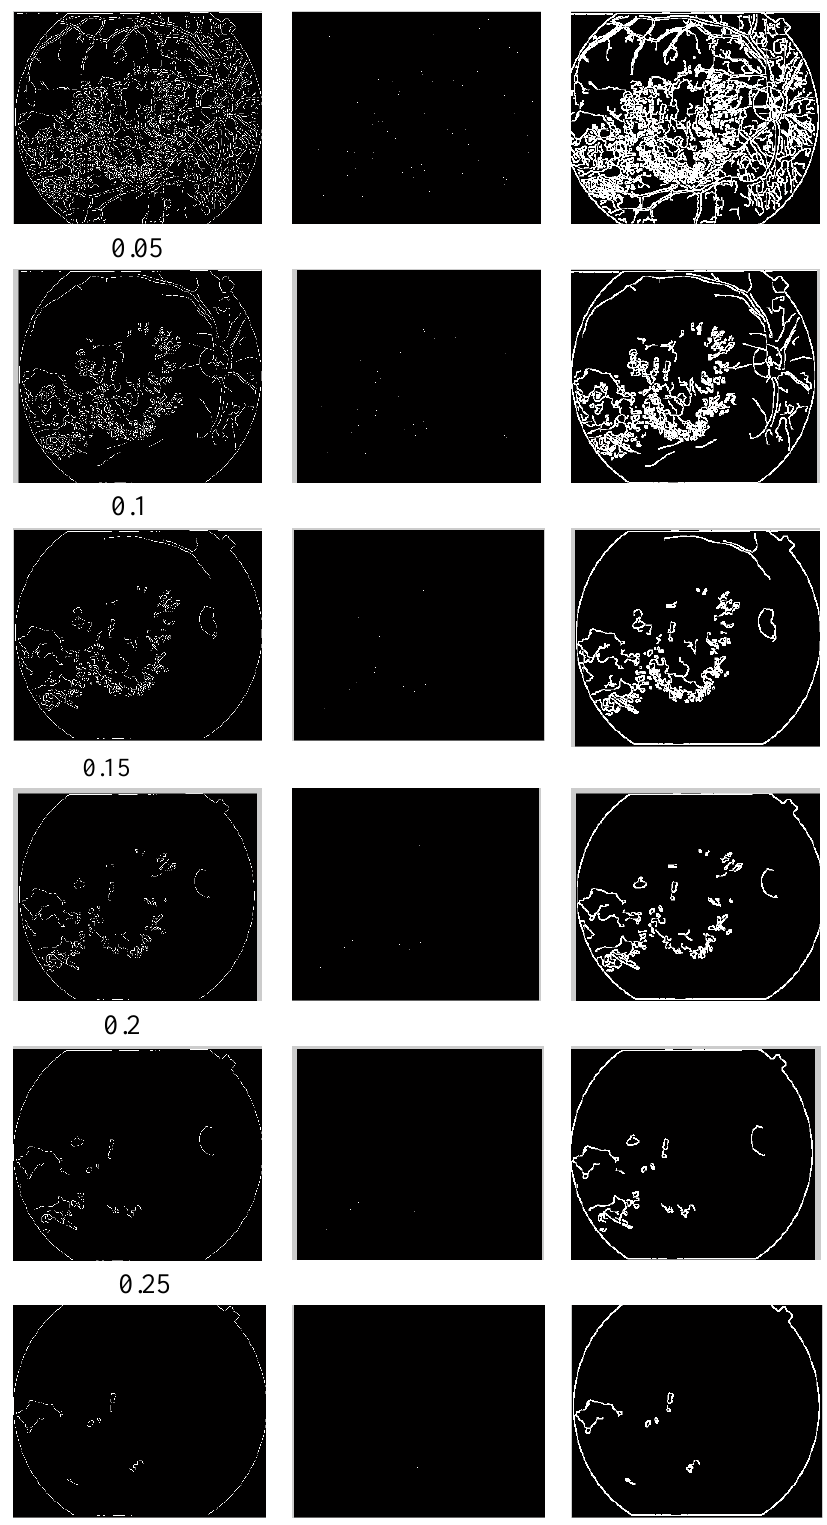
Fig.8: From left to right, canny edge detector binary image, binary image after erosion, and binary image after dilation with thresholds: 0.25, and 0.3